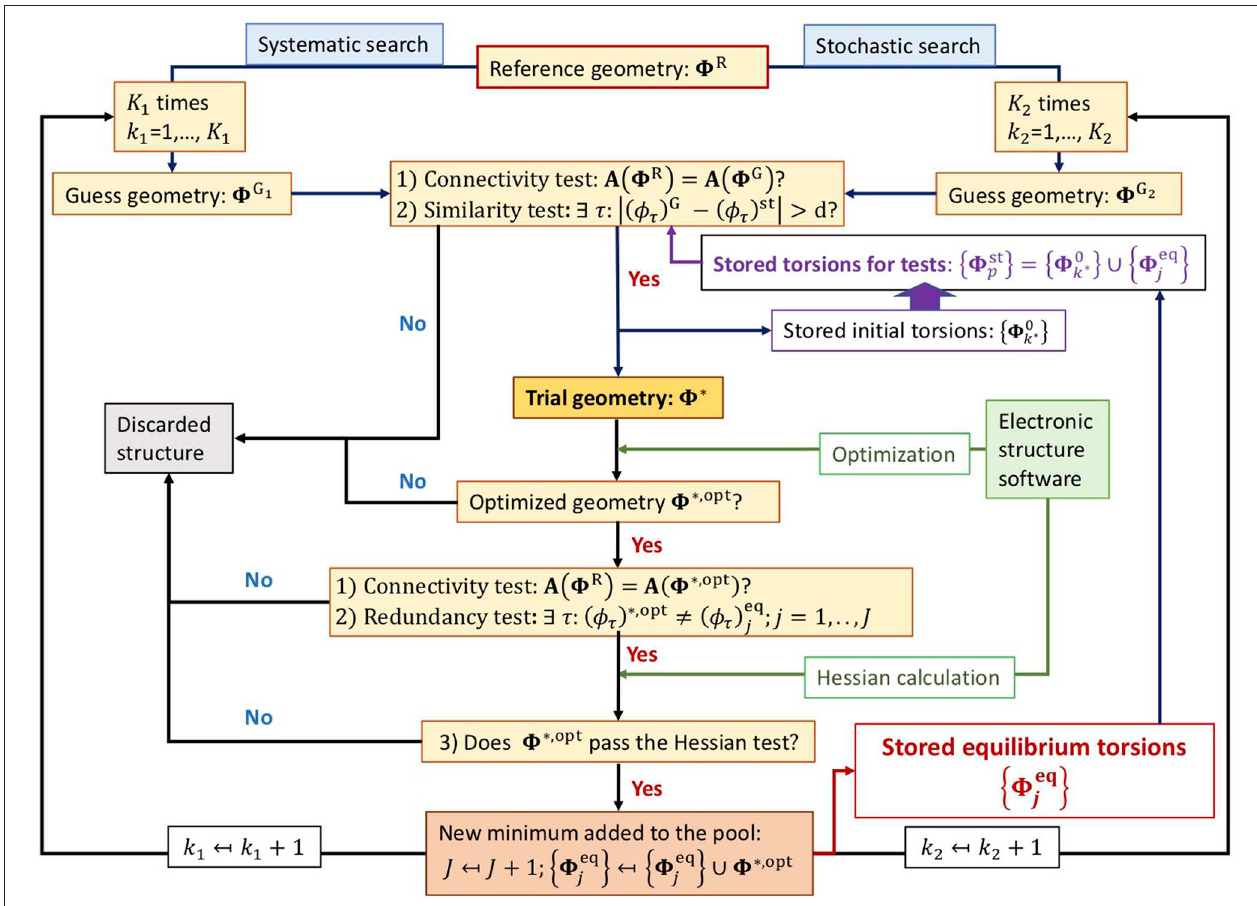
FIGURE 1 | Flux diagram of the conformer search